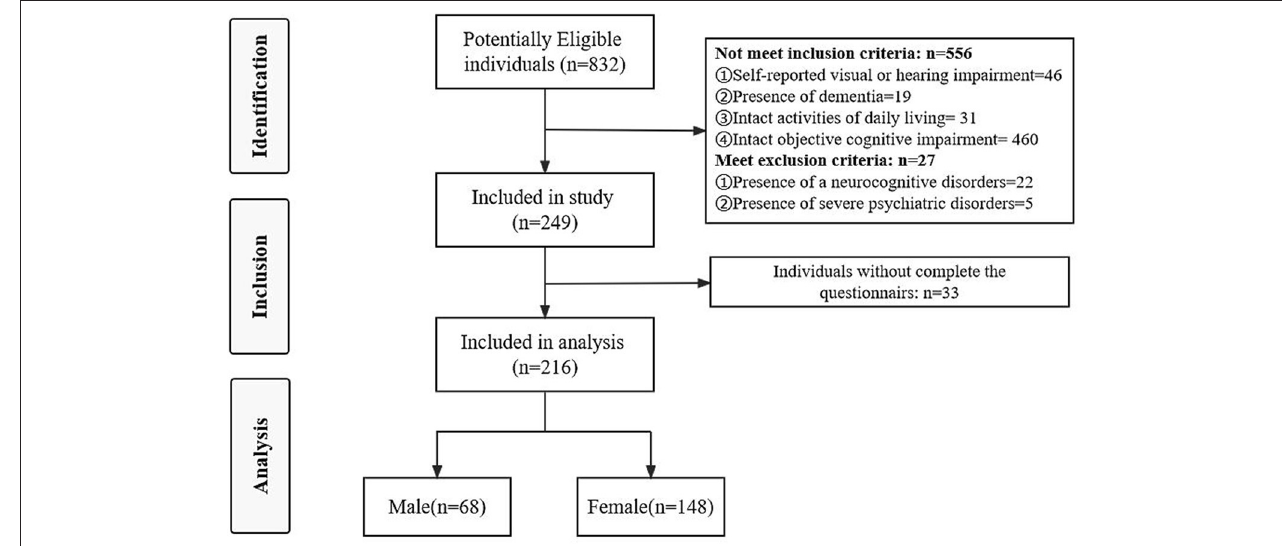
FIGURE 1 | Flow diagram of participants recruitment for a cross-sectional study.